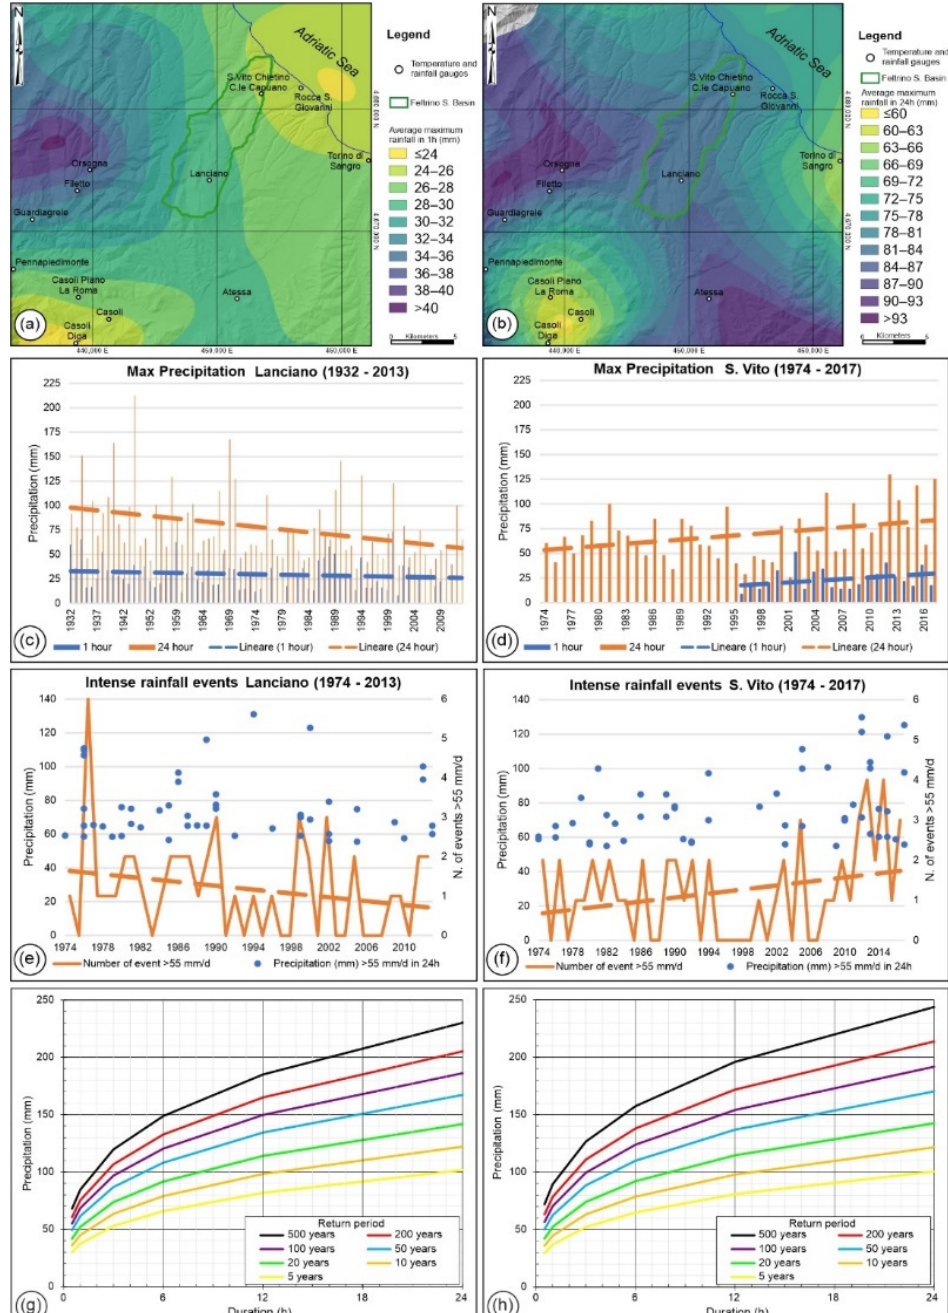
Figure 5. Maximum precipitation distribution in the study area. ( a ) Distribution of average maximum rainfall over 1 h; ( b ) distribution of average maximum rainfall over 24 h; ( c ) diagram of the maximum precipitation over 1 h and 24 h in each year (Lanciano 1932–2009); ( d ) diagram of the maximum precipitation over 1 h and 24 h in each year (S. Vito 1974–1995 S. Vito Chietino; 1996–2017 S. Vito–C.le Capuano); ( e ) diagram of the intense precipitation and number of intense events (>55 mm/24 h) of the Lanciano gauge (1974–2013); ( f ) diagram of the intense precipitation and number of intense events (>55 mm/24 h) of the S. Vito gauges (1974–1995 S. Vito Chietino; 1996–2017 S. Vito–C.le Capuano); ( g ) precipitations return periods (1–24 h) for the Lanciano gauge (Gumbel distribution); ( h ) precipitations return periods (1–24 h) for the Lanciano gauge (lognormal distribution).